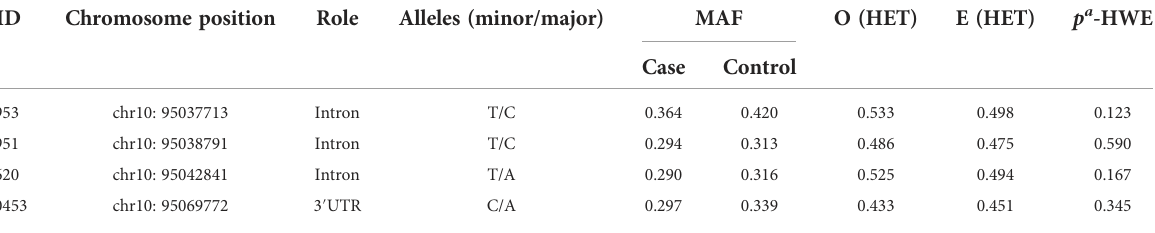
TABLE 3 Basic information and allele frequencies of CYP2C8 SNPs.